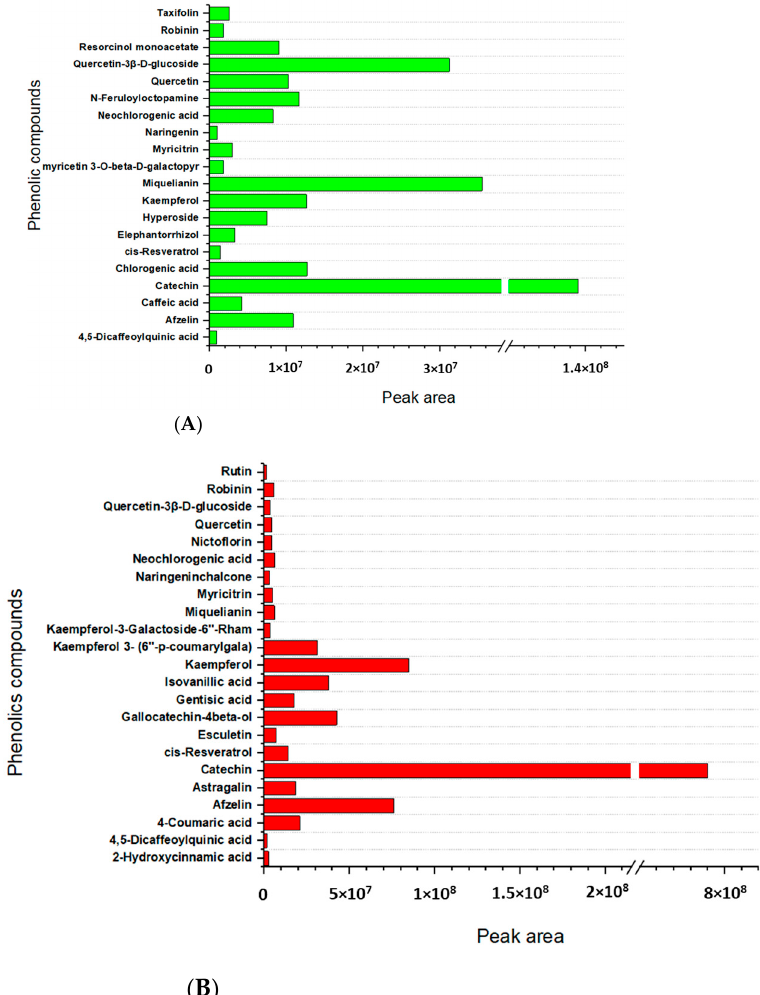
Figure 3. Comparative analysis based on peak areas that were calculated for phenolic compounds that were found in Eston green (panel A ) and Crimson red (panel B ) hulls. The peak area of each phenol was retrieved using the software Compound Discoverer 3.3.